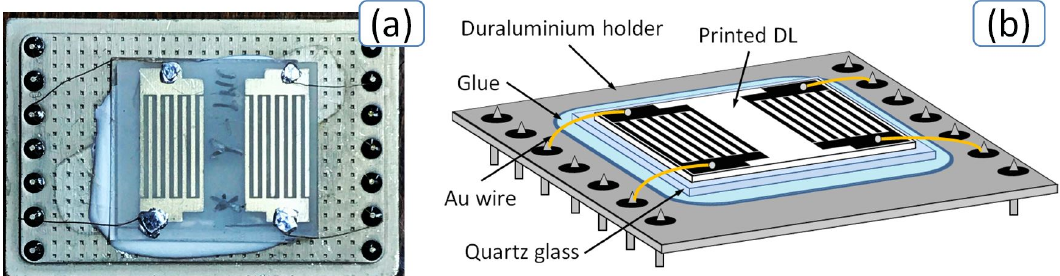
Figure 8. Optical microscopy image ( a ) and scheme ( b ) of the final chip with plate acoustic wave (PAW) device.